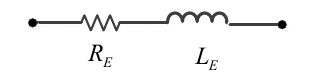
Figure 2. Equivalent circuit of electromagnetic part.